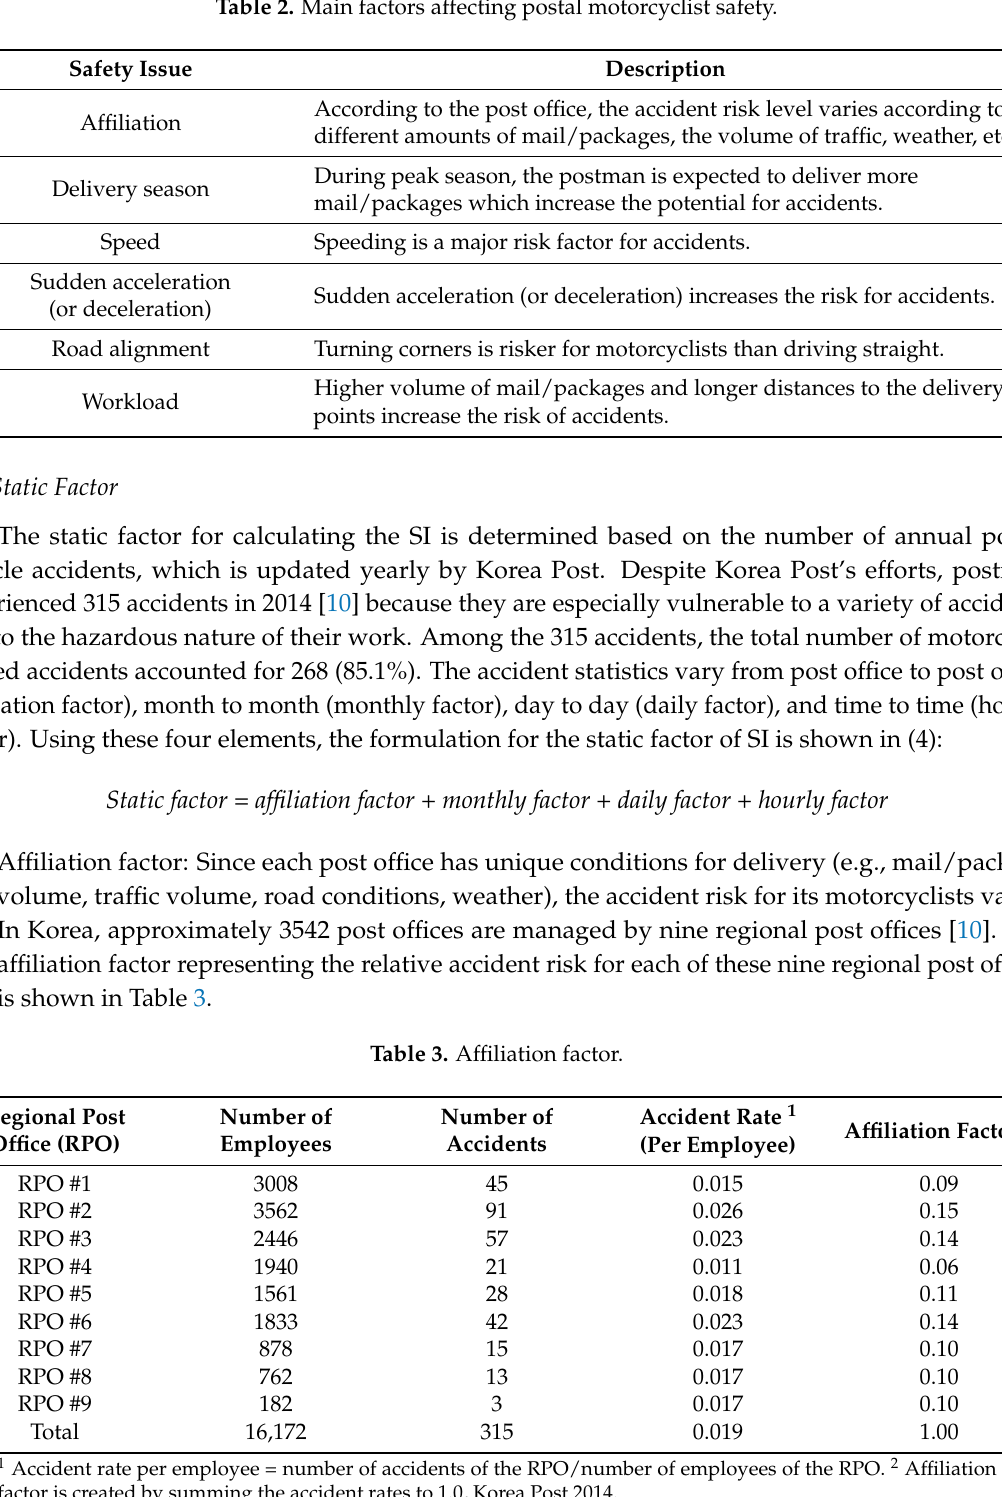
Table 2. Main factors affecting postal motorcyclist safety.